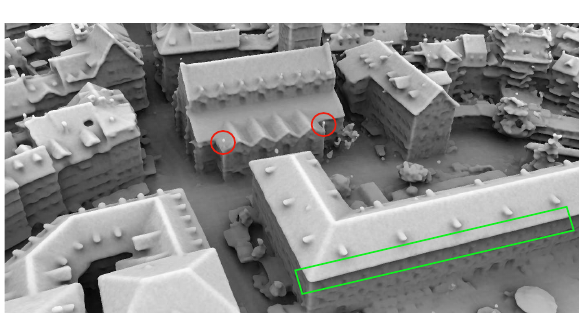
Figure 9: Mesh representation of the urban scenario. Clear edges (green rectangle) and small details as poles on the church roof (red circles) are successfully